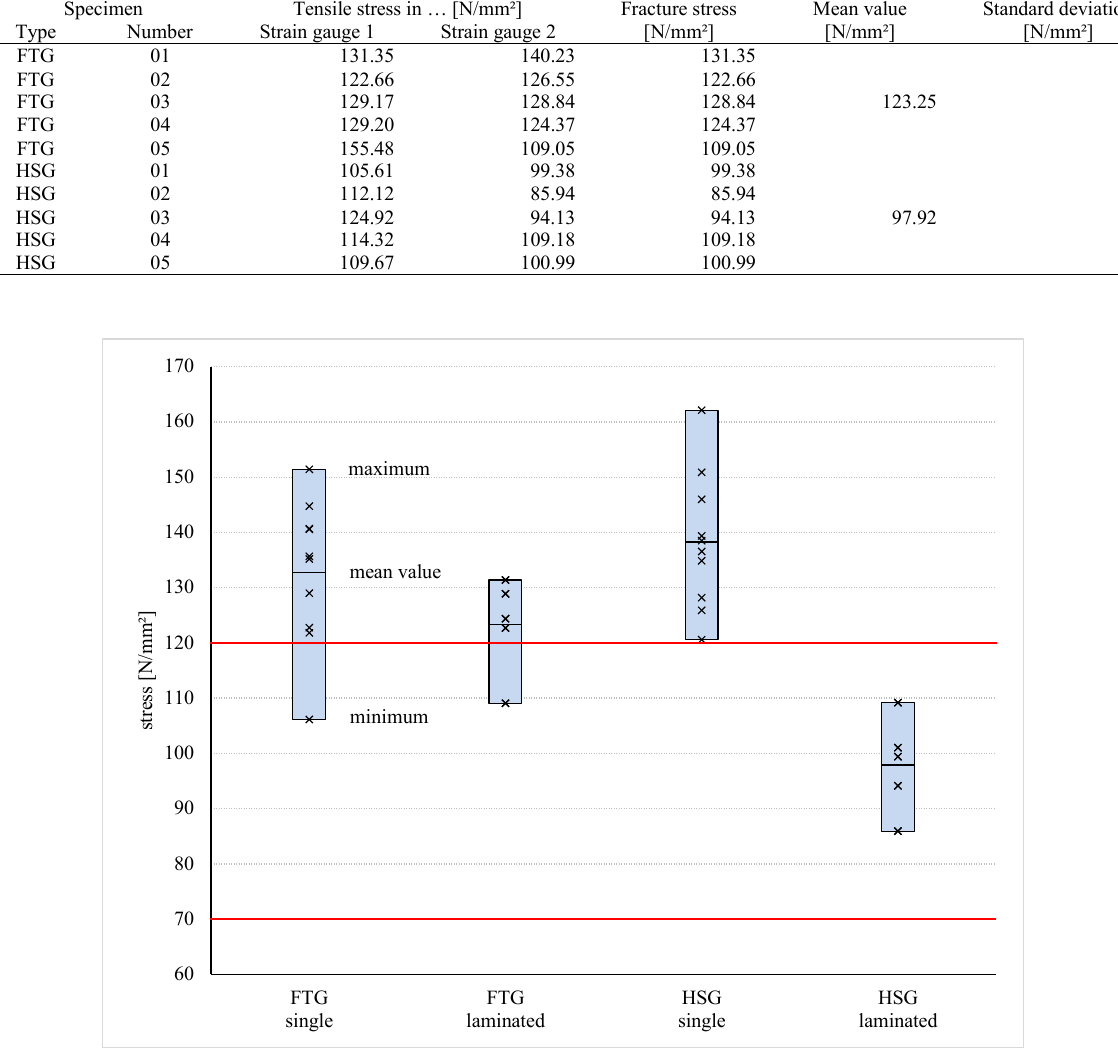
Fig. 9 Fracture stresses of the beams with 3 mm reground depth with minimum, maximum, mean value and individual